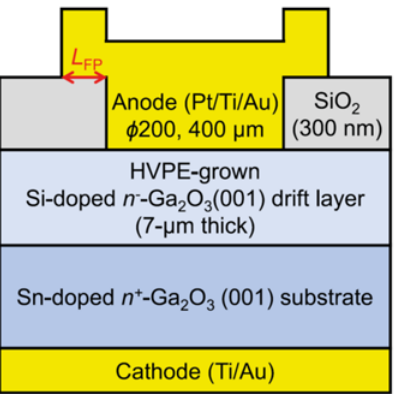
Figure 4. Device diagrams of SBD with field plates. Reprinted from [97], with the permission of AIP Publishing.